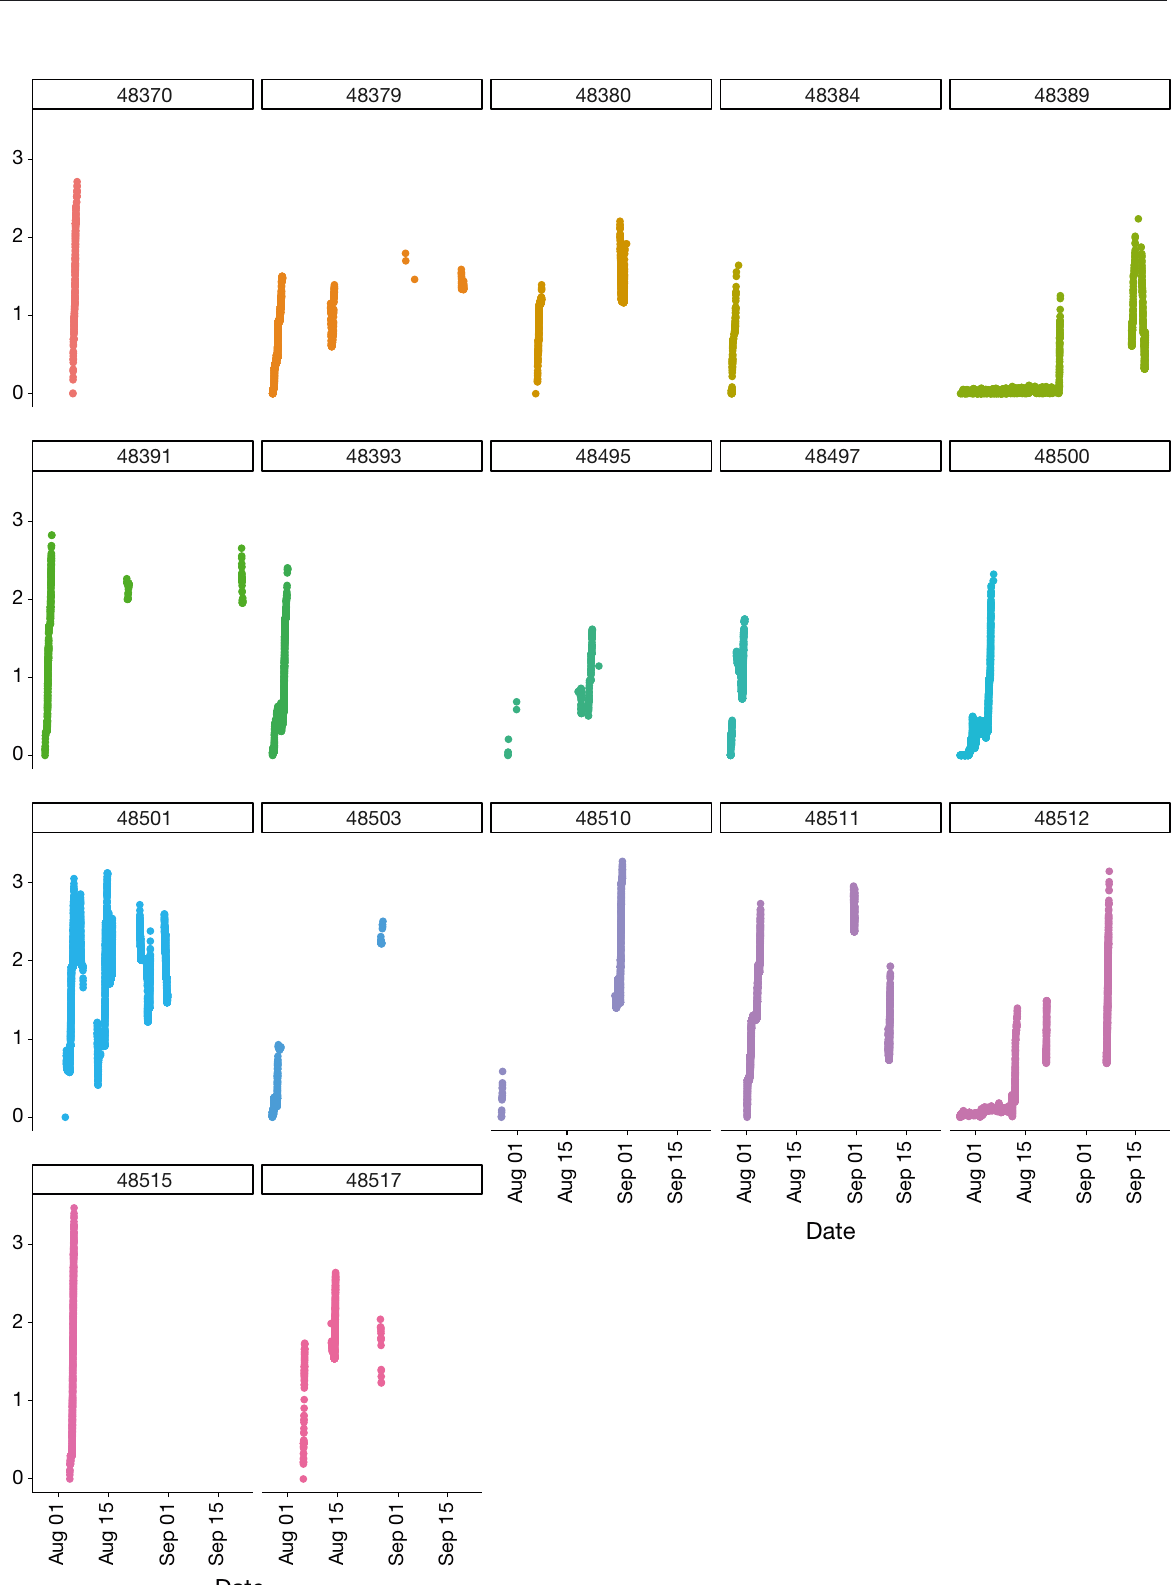
Fig. 6. Net squared displacement for each lobster that stayed or returned to acoustic array during post-acclimation in 2017 (n = 17). Numbers above each panel are individual lobster